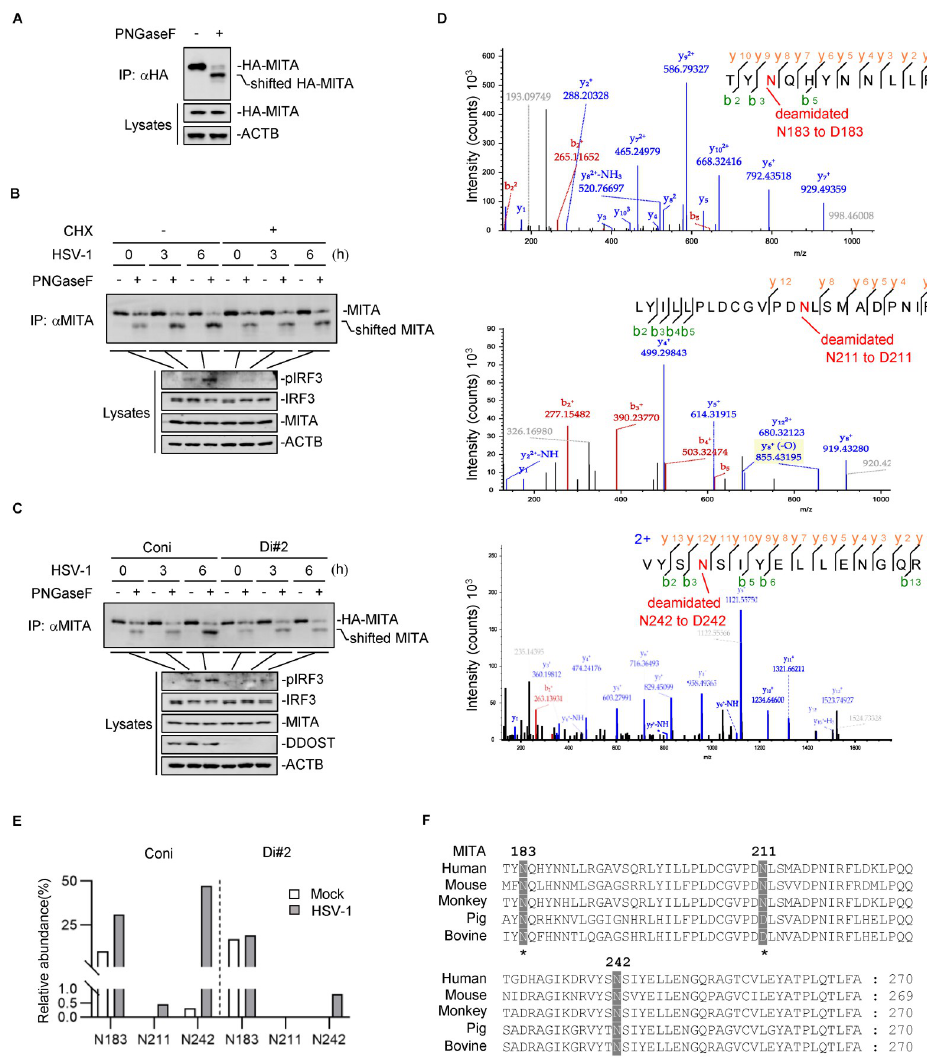
Fig 4. DDOST mediates the N-glycosylation of MITA upon viral infection. (A) Cell lysates of HA-MITA- transfected HEK293T cells were immunoprecipitated with an anti-HA antibody. The beads coupled with HA-MITA were incubated with PNGase F or control buffer at 37˚C overnight before the immunoblotting analysis. (B) THP-1 cells were treated with or without 20 μ M CHX and infected with HSV-1 (MOI = 2) for the indicated times. Then, immunoprecipitation assays were performed with an anti-MITA antibody (ABclonal, A3575) followed by digestion with PNGase F and immunoblotting. One representative result from at least three independent experiments is shown. (C) DDOST knockdown THP-1 cells and control cells were infected with HSV-1 (MOI = 2) before immunoprecipitation with anti-MITA antibody (ABclonal, A3575) and digestion with PNGase F. One representative result from at least three independent experiments is shown. (D, E) Immunoprecipitated endogenous MITA in DDOST knockdown THP-1 cells and control cells untreated or treated with HSV-1 (MOI = 2) for 6 hours was digested with PNGase F and then analyzed by LC–MS/MS to identify N-glycosylation sites of MITA. PNGase F cleaves the amide bond of N-glycosylated Asn and converts Asn to Asp. The b - and y -series fragment ions derived from a certain N-glycopeptide moiety are displayed (D). The abundance of N-glycopeptides to total peptides was calculated and displayed (E). (F) Sequence alignment of MITA homologs in humans, mice, pigs, green monkeys, and bovines. and N242 was inhibited, suggesting that DDOST mediates the glycosylation of MITA at these three residues (Fig 4E). Sequence alignment demonstrated that N183 and N242 of MITA were highly conserved in humans, mice, green monkeys, pigs, and bovines (Fig 4F).